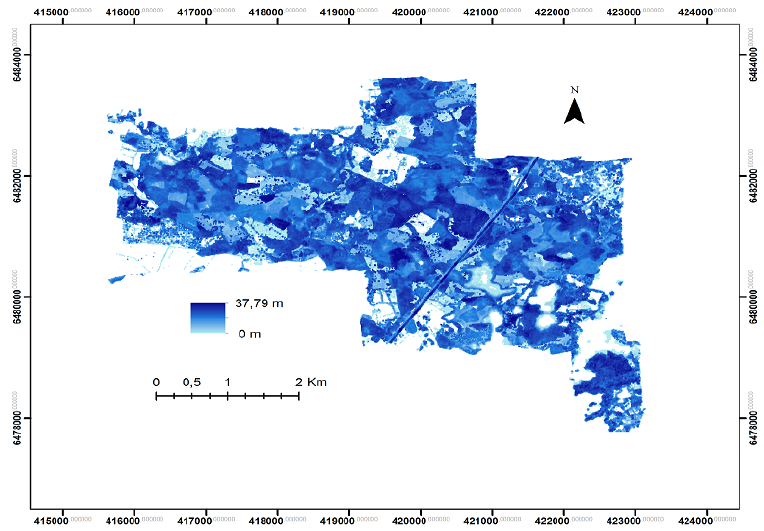
Figure 7. Resulting height map from the RMoG L